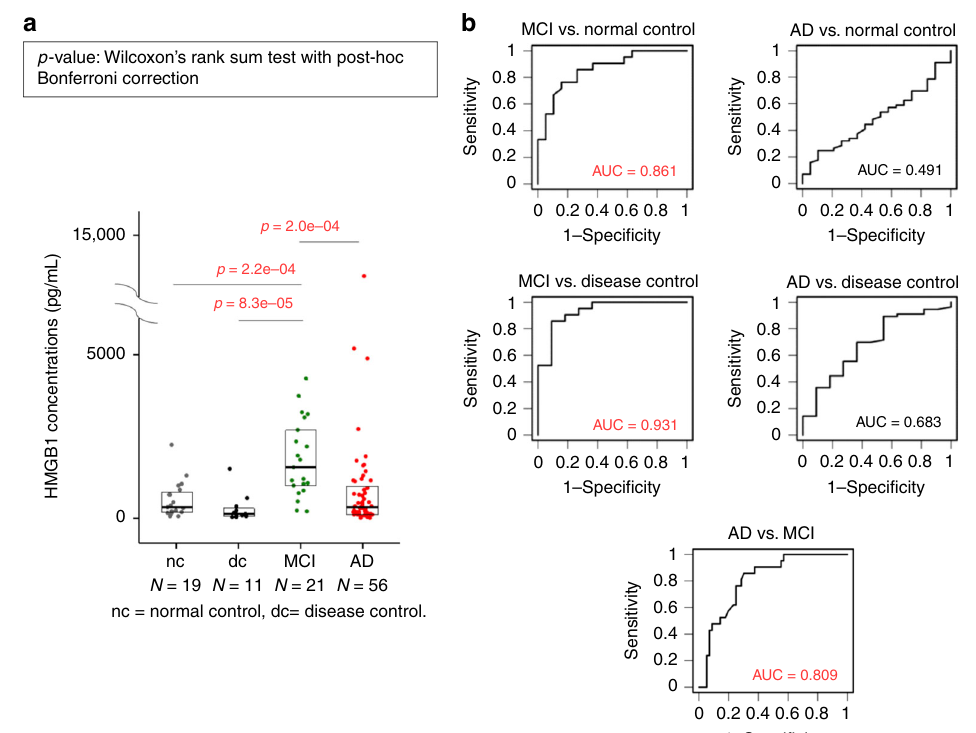
Fig. 1 HMGB1 levels are elevated in the CSF of MCI and AD patients. a CSF-HMGB1 levels in the normal control (nc) ( N = 19 persons), disease control (dc) ( N = 11 persons), MCI ( N = 21 persons), and AD ( N = 56 persons) groups were evaluated by high-sensitivity ELISA. The box plot shows the median and quartiles. Statistical differences among groups were evaluated using the Wilcoxon rank – sum test with post-hoc Bonferroni correction. b Receiver operating characteristic (ROC) curves for the MCI or AD group versus the normal control (nc) and disease control (dc) groups. Area under the ROC curve (AUC) values are shown in the graphs. Source data are provided as a “ Source Data fi le ”